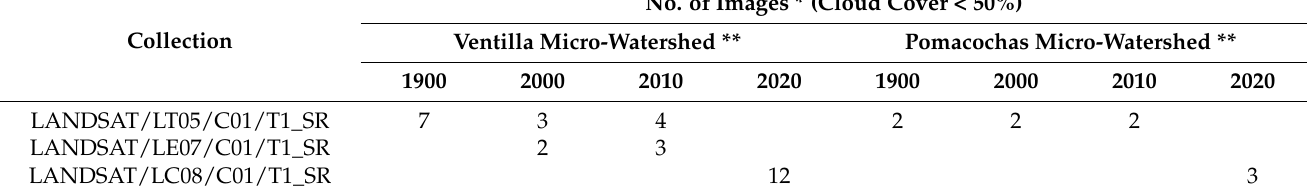
Table 1. Spatial and spectral general characteristics and number of images per year for the Landsat 5, 7 and 8 collections.